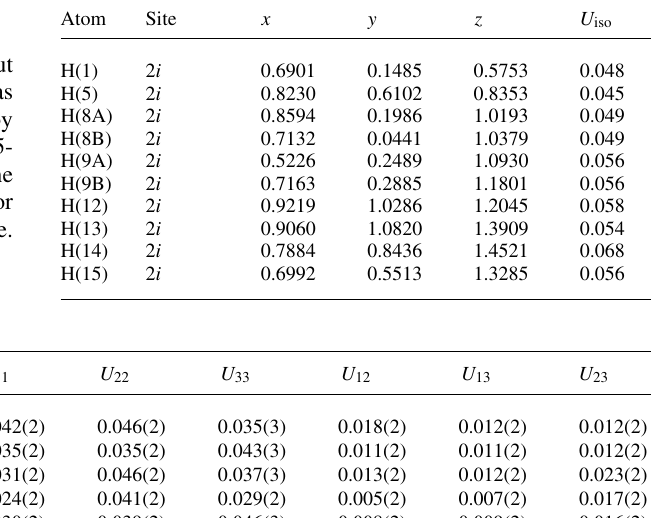
Table 2. Atomic coordinates and displacement parameters (in Å 2 ) .